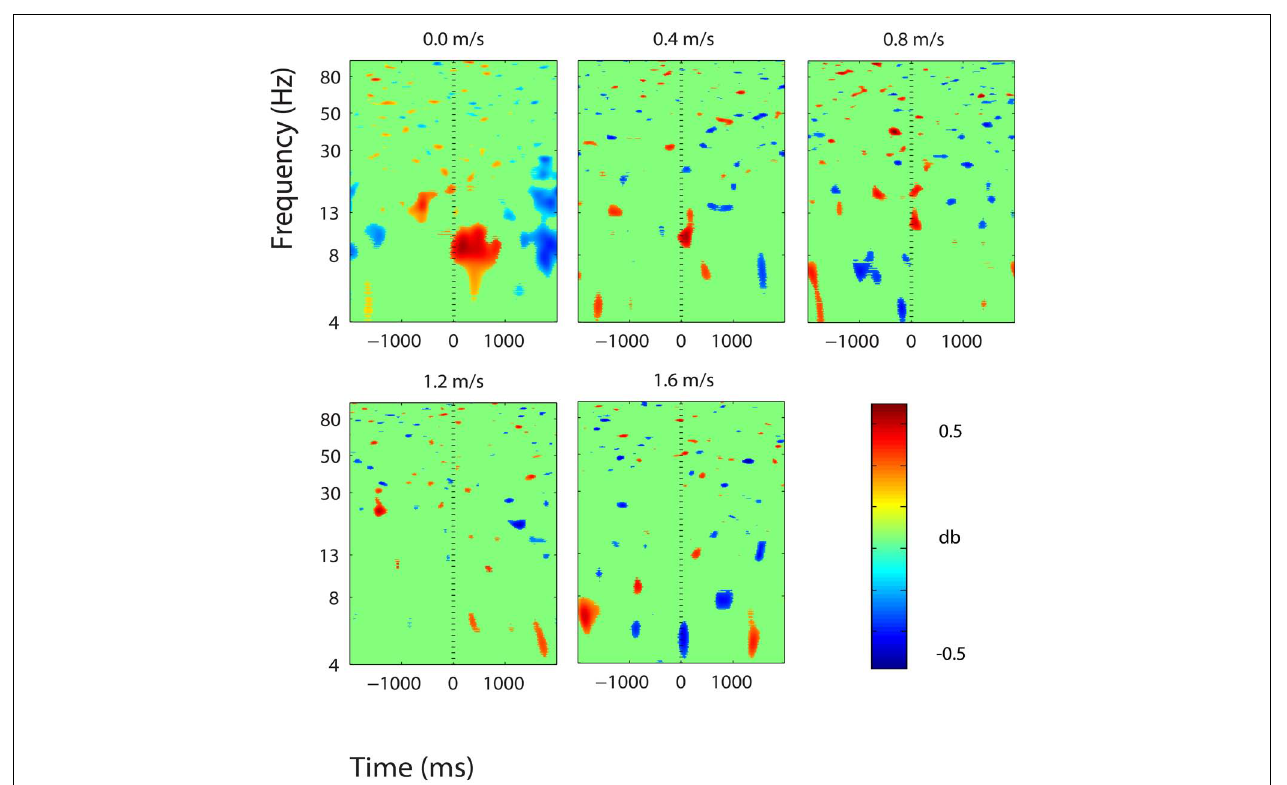
FIGURE 8 | Event-related spectral perturbation plots showing power change around the presentation of a stimulus (a digit and its position in an imagined grid) in the premotor and supplementary motor cortex (BA 6). Red represents a power increase from baseline